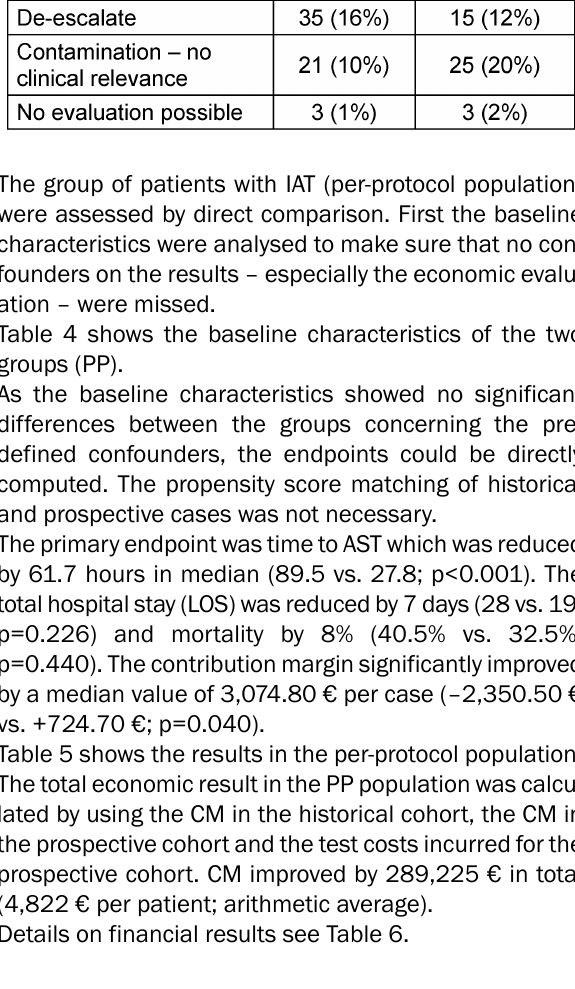
Table 3: Results of the AT assessment in both cohorts